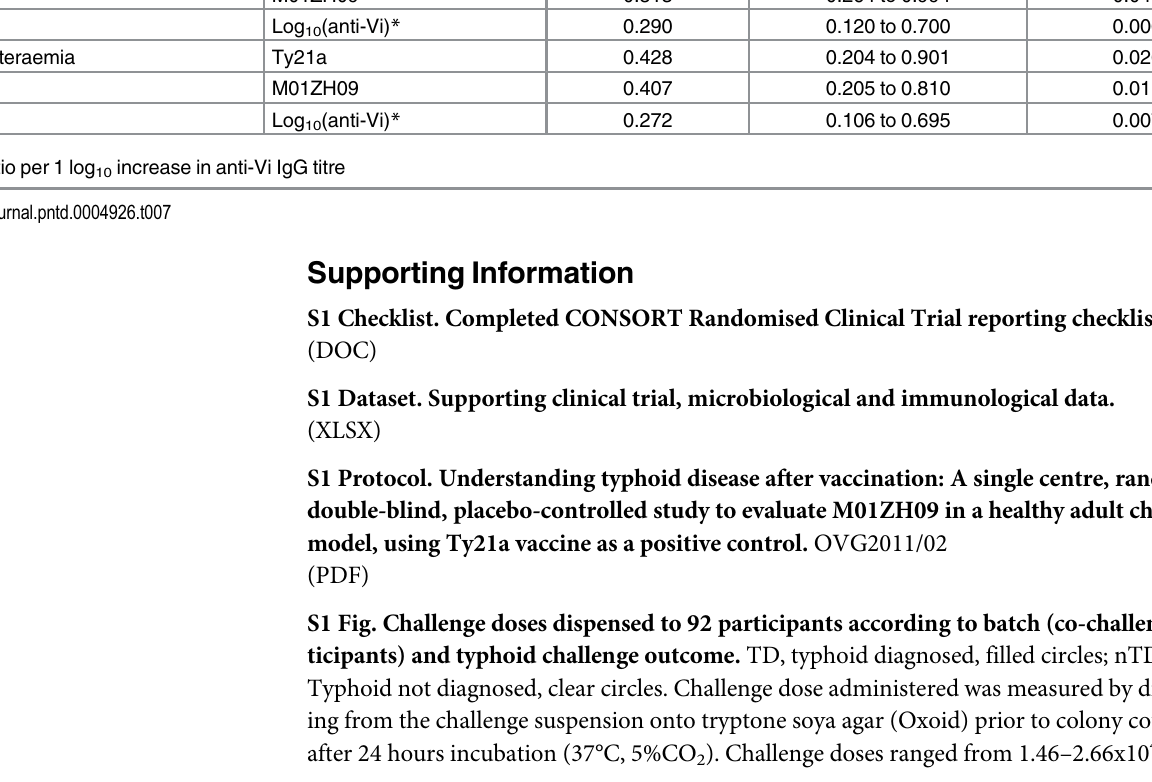
Table 7. Hazard Ratios (each active vaccine group vs. placebo) and 95% confidence intervals from proportional hazards models adjusting for baseline anti-Vi IgG antibody titres. Predictor HR 95% CI Time to typhoid